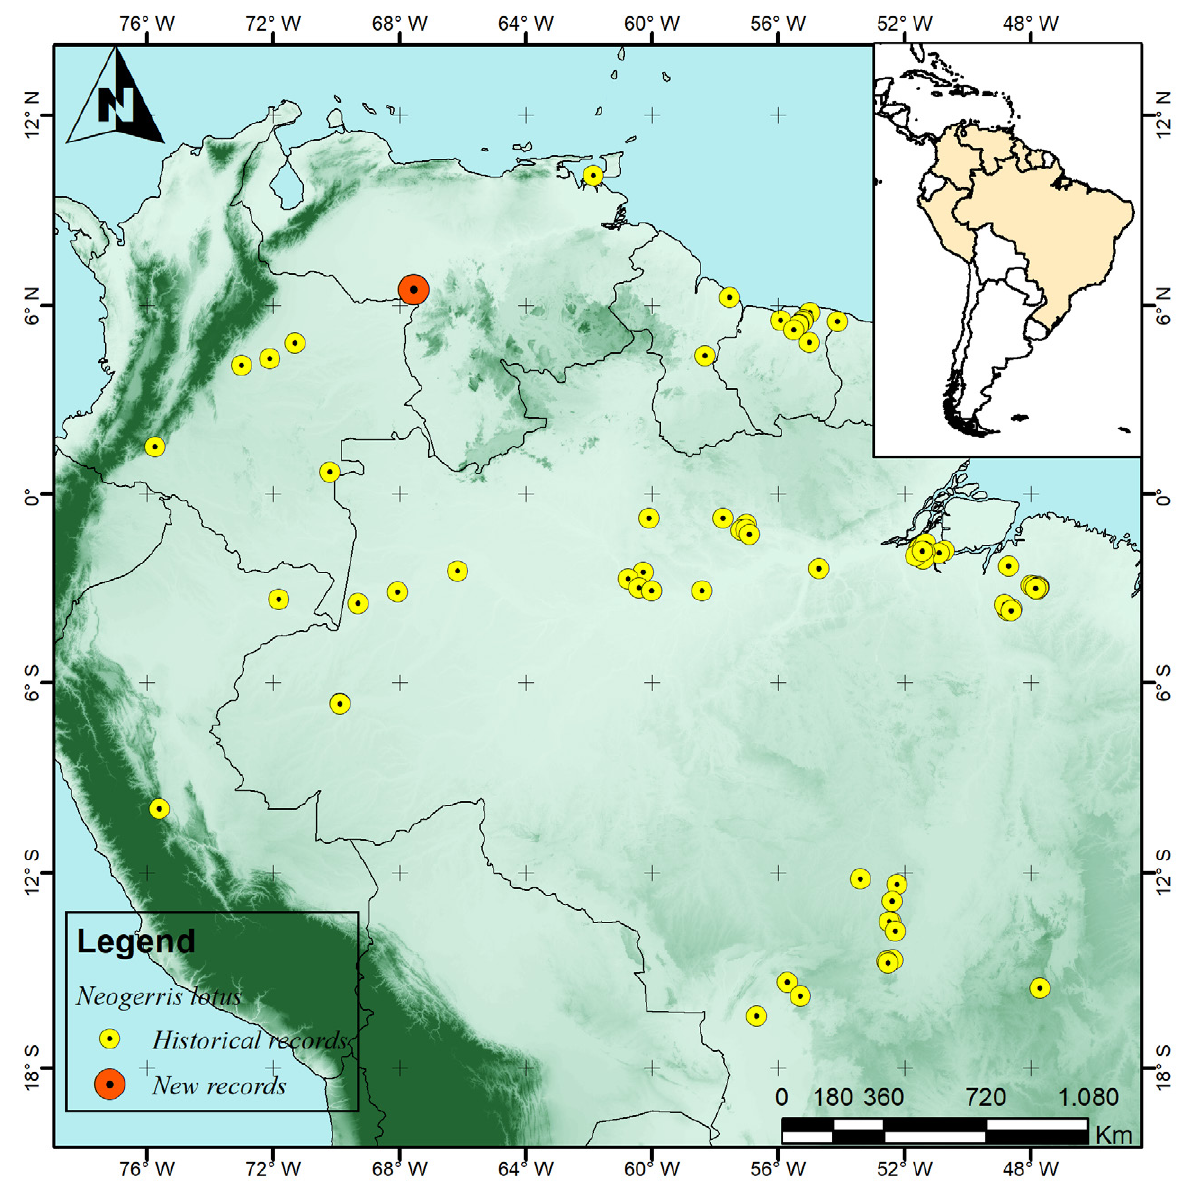
Figure 5. Historical and new records of Neogerris lotus in the